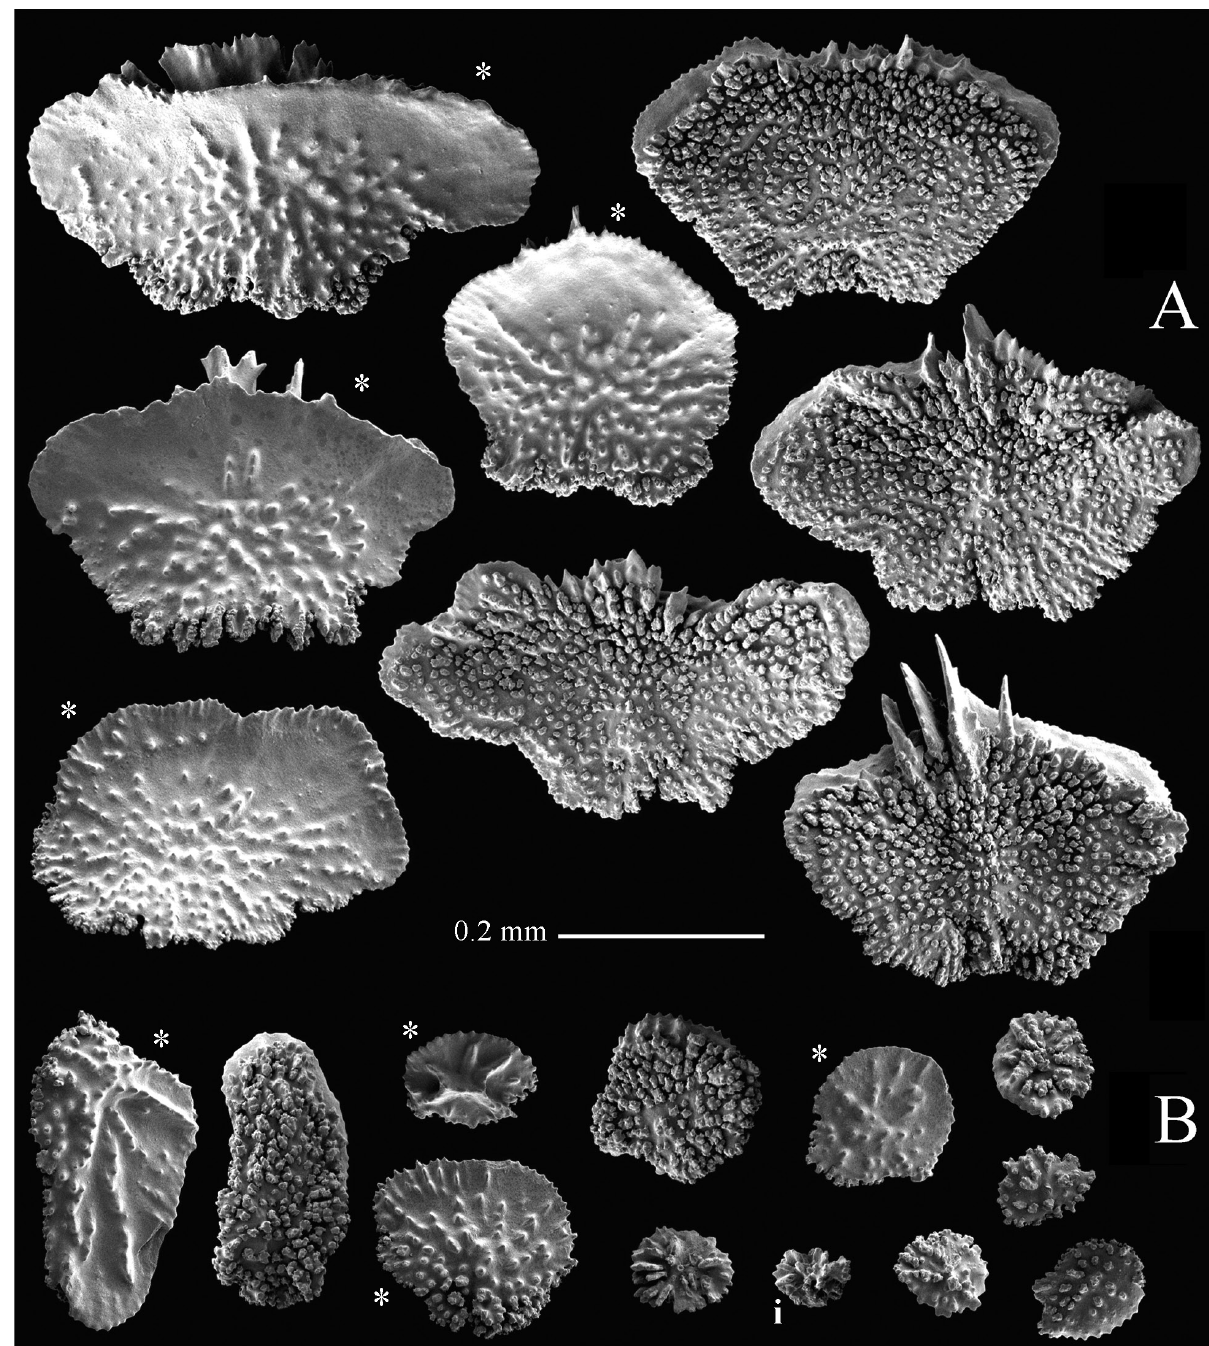
Fig . 6. – Thouarella regularis (Wright and Studer, 1889), lectotype (NHMUK 1889.5.27.60): A, body scales; B, coenenchymal sclerites. [ * outer surface view; i sclerite from inner